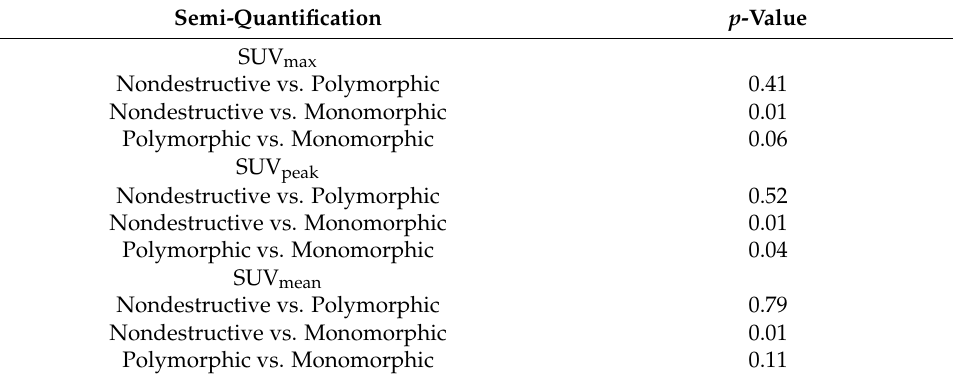
Table 3. Adjusted pairwise semi-quantitative